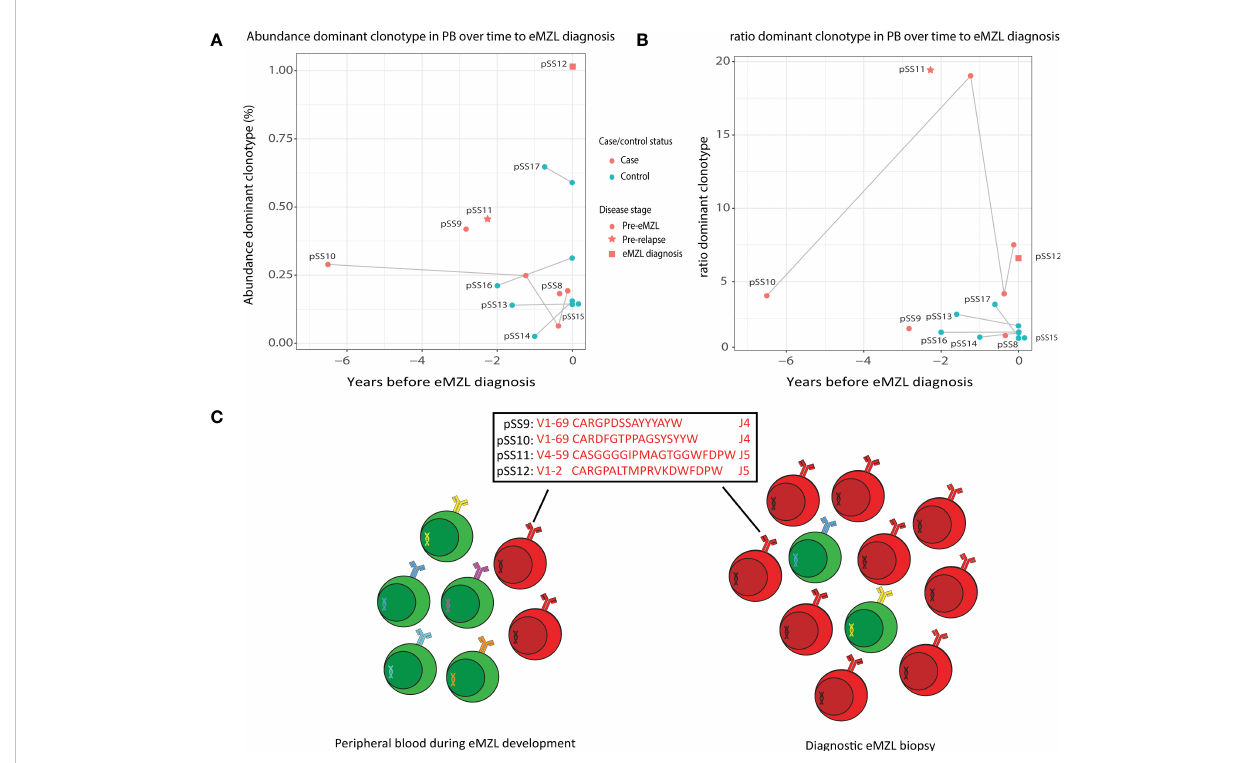
FIGURE 2 Abundance of eMZL clonotype in peripheral blood of pSS patients. (A) The abundance (% of total reads in the IG gene repertoire) of the eMZL clonotype in pSS patients is shown over time until eMZL diagnosis in comparison to matched pSS controls. For controls, the abundance of the dominant clonotype is shown. (B) The ratio (#1 clonotype divided by the mean of clonotype #3-#7) in pSS patients is shown over time to eMZL diagnosis in comparison to matched pSS controls. PBMC samples and matching diagnostic biopsies are further described in Supplementary Table 3. (C) Schematic overview of early detection of premalignant eMZL clonotypes. The eMZL clonotypes identi fi ed in both tissue biopsy and the peripheral blood in the current study are